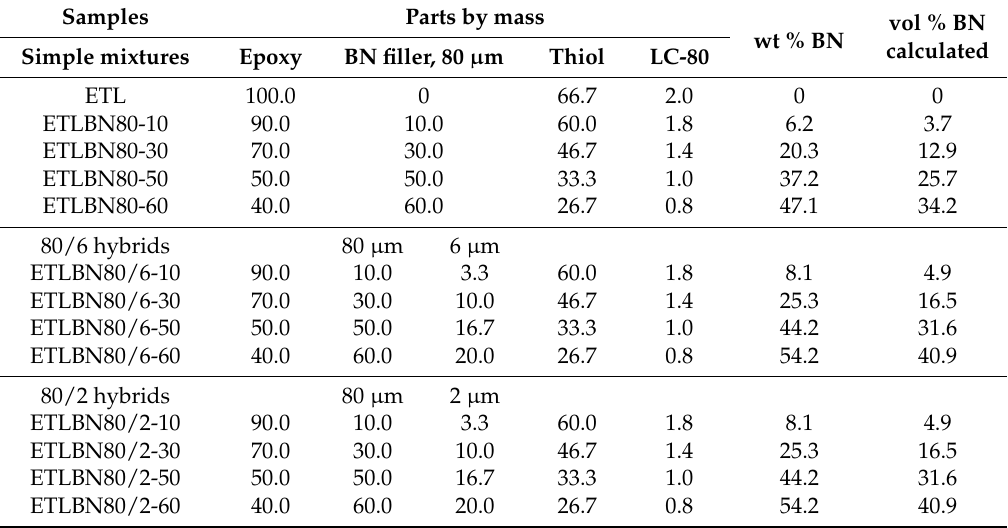
Table 1. Composition of samples: parts by mass, wt % BN and the approximate vol % BN.